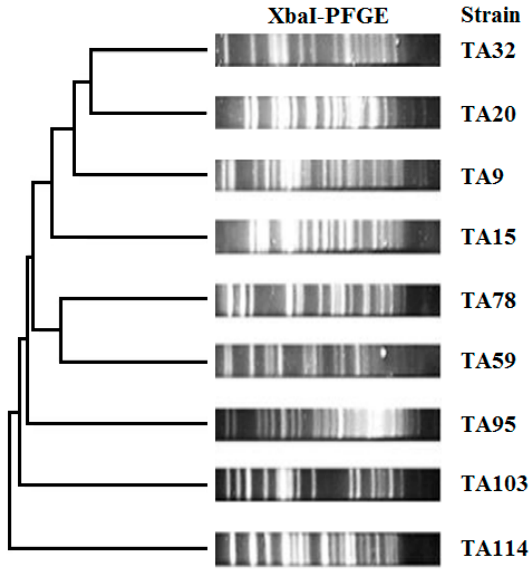
Figure 1. XbaI-PFGE dendrograms showing the genetic relationships of the 9 mcr-1 -positive E. coli strains isolated in this study.